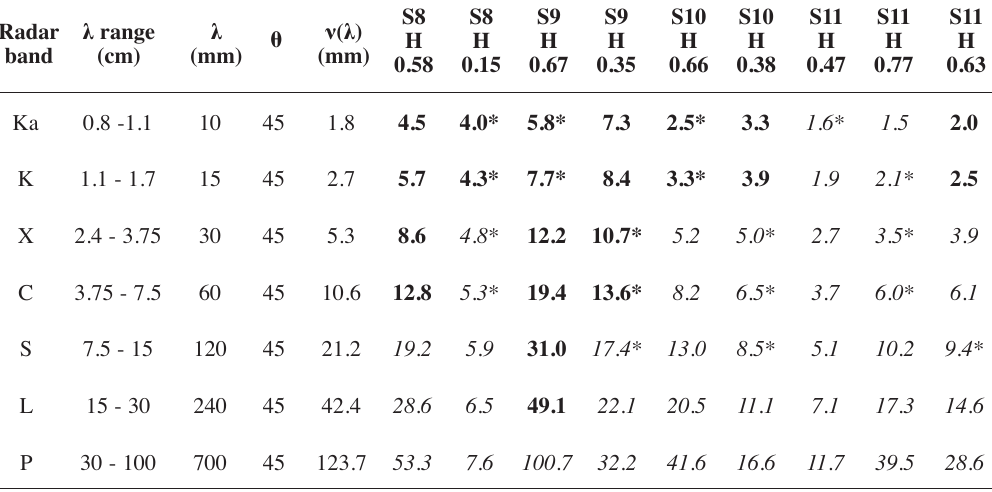
Table II. Surface roughness of sampled tephra in the wavelength of Radar bands. Radar λ